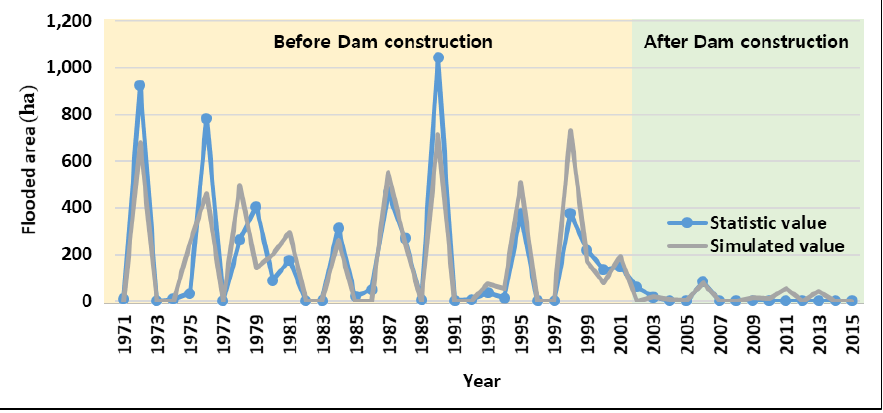
Figure 8. Calibration results—Flooded area.